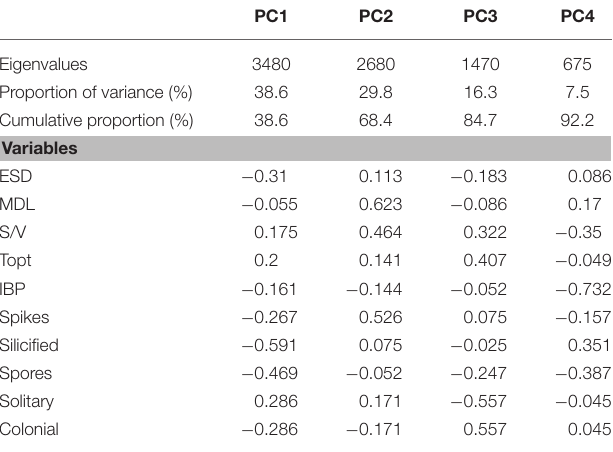
TABLE 2 | List of factor loadings of PCA on traits used in this